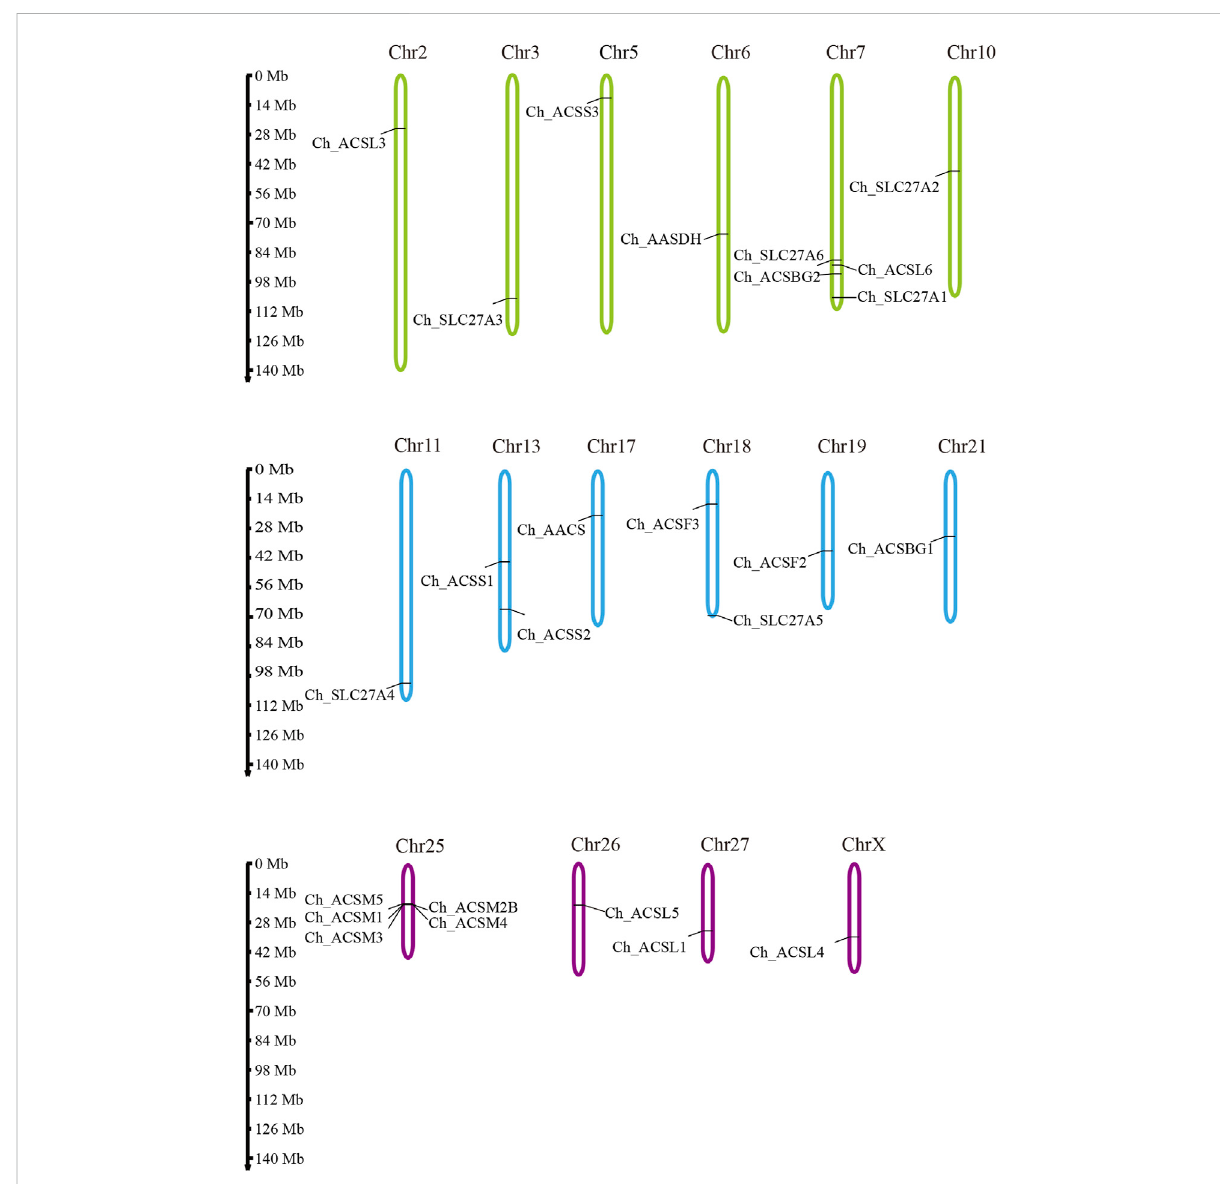
FIGURE 4 The chromosomal distribution of ChACS genes. Legends: The chromosomal position of each ACS gene was mapped to the goat genome. The chromosome number is indicated at the top of each chromosome.